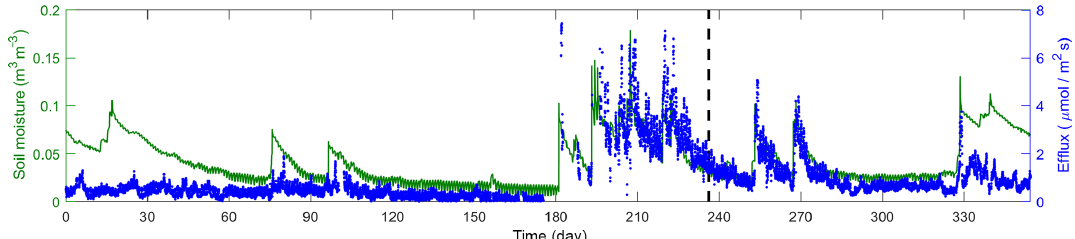
Figure 2. Time series of soil moisture and efflux observations. The dashed line marks the divide of the dataset into calibration and validation